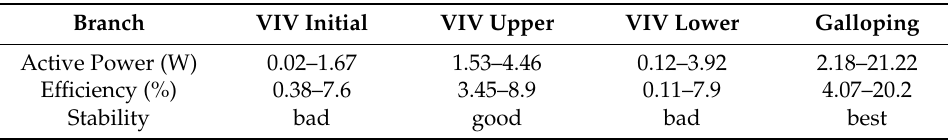
Table 6. Power generation characteristics of different branches.